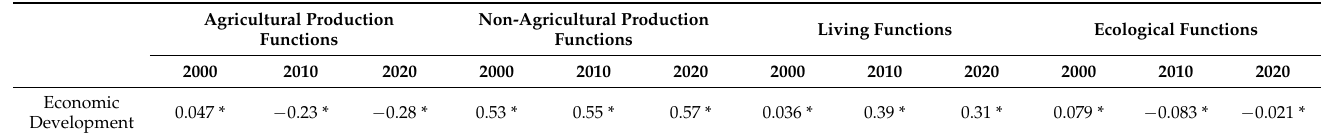
Table 2. Correlation between land use function index and economic development